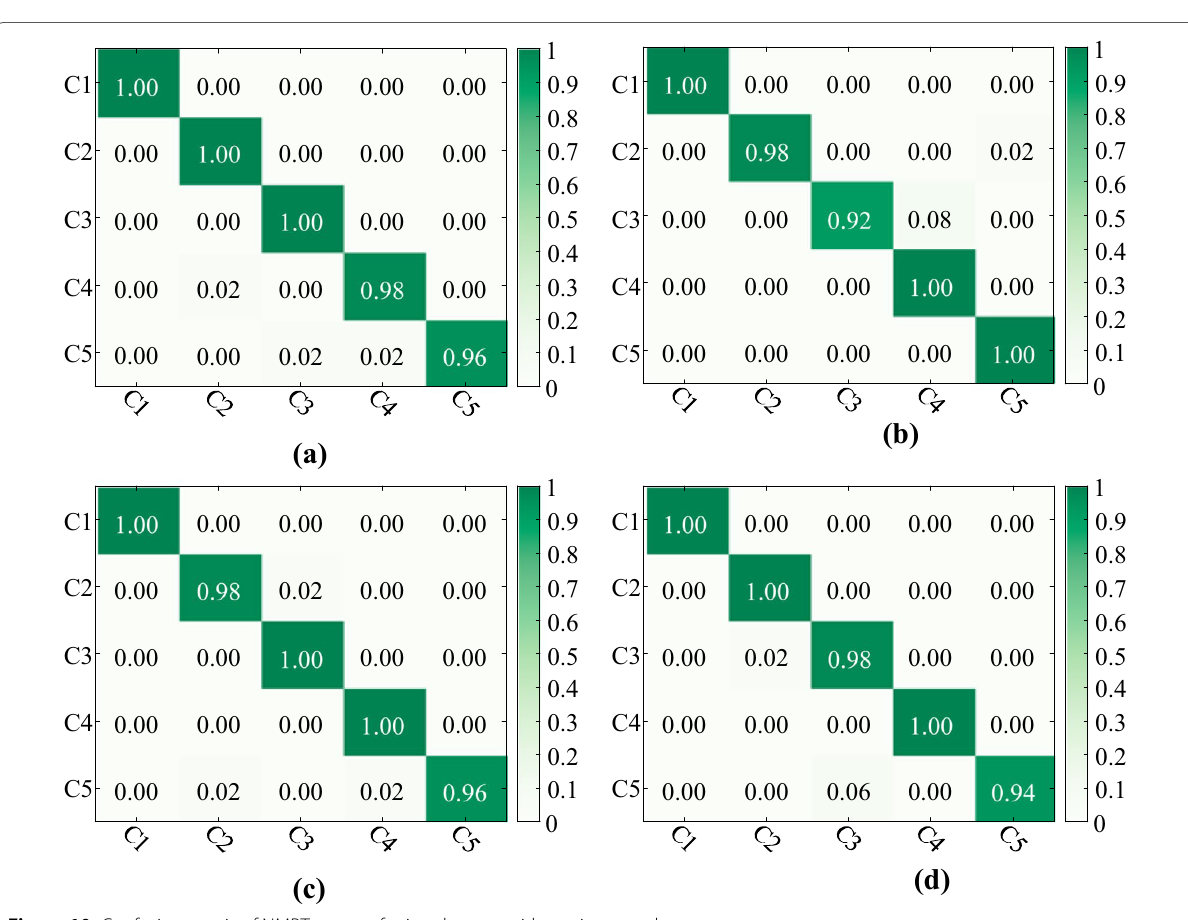
Figure 10 Confusion matrix of NMPT on transferring datasets with varying